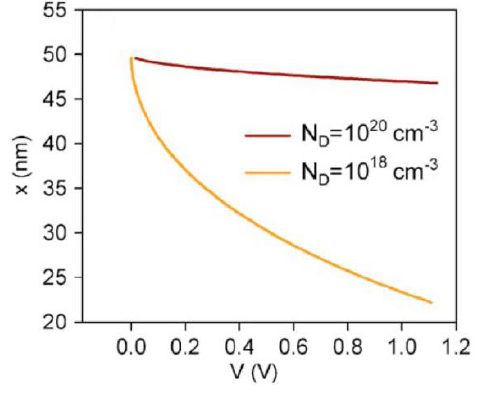
Figure 10. Simulation result of radius of the neutral region vs barrier voltage for different quantities for nanowire of radius R = 50 nm and length L = 1,000 nm, density of nanowires per flat unit area D = 3 × 10 9 cm −2 , flat area S = 1 cm 2 , and ε nw donor densities N = 10 18 and N = 10 20 cm −3 (adopted from Ref. [49]). D D